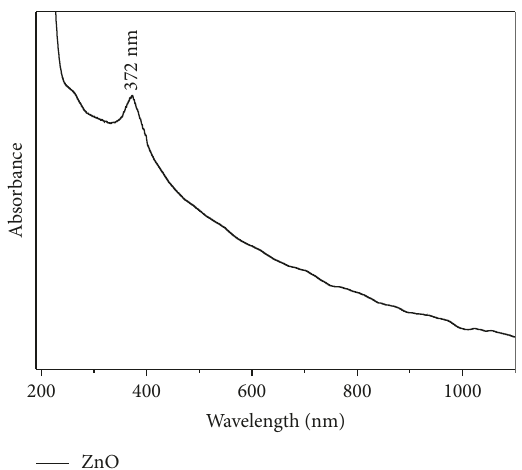
Figure 1: UV-Visible absorbance spectrum of